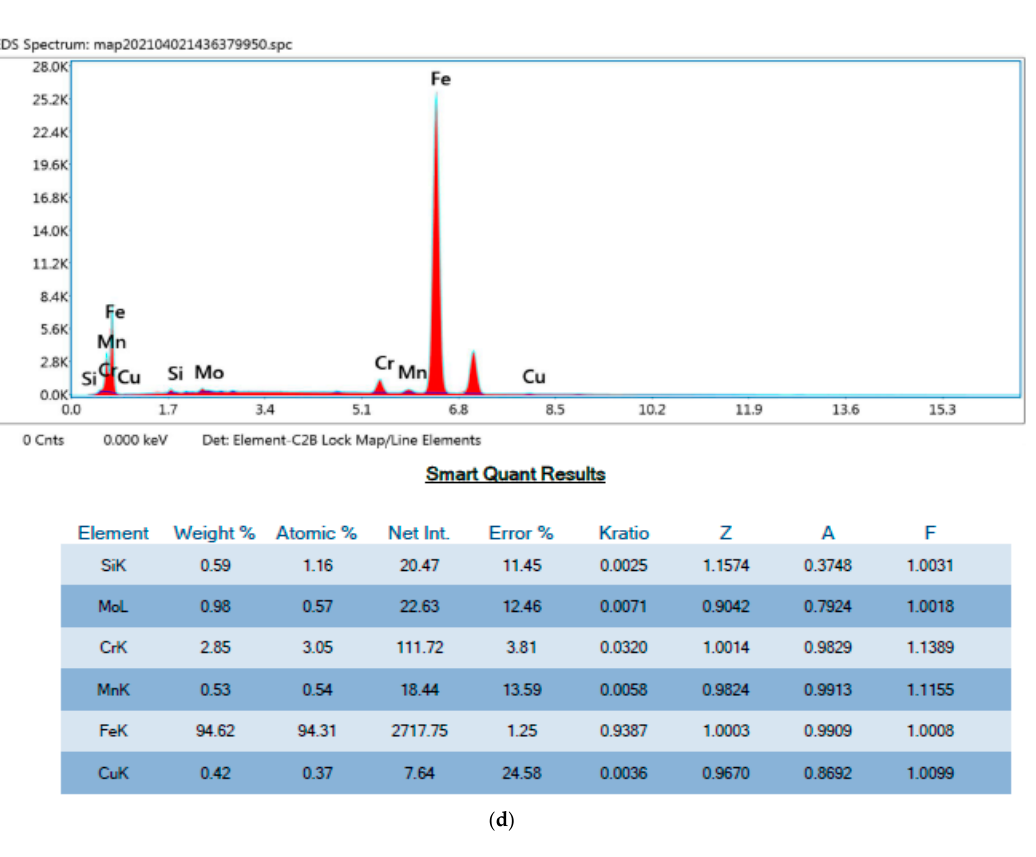
Figure 6. ( a ) EDS spectrum for the Si element from the 10CrMo9-10 steel sample. ( b ) EDS spectrum for the Cr element from the 10CrMo9-10 steel sample. ( c ) EDS spectrum for the Fe element from the 10CrMo9-10 steel sample. ( d ) The spot chemical analysis in the selected area for the 10CrMo9-10 steel sample.